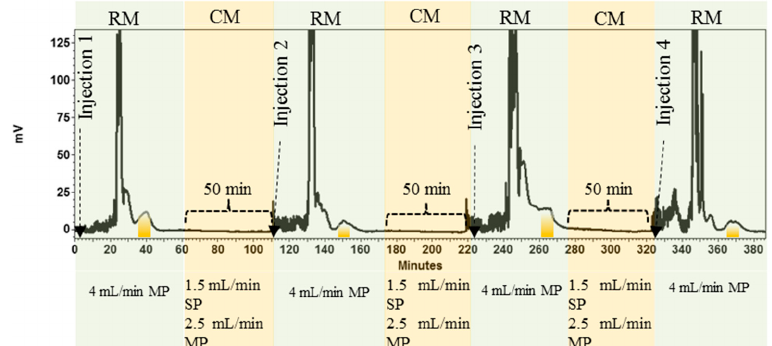
Figure 4. Isolation of myxoxanthophyll by a multi-injection HPCCC method. Biphasic solvent system: System 7 ( n -Hep:EtOH:H 2 O, 2:4:4, v / v / v ). Elution modes: Reverse (RM) and co-current (CM) elution modes. Loading per injection: 70 mg of S. salina extract. Runs: 4 consecutive injections. MP: mobile phase (lower phase of system 7). SP: stationary phase (upper phase of system 7). Rotational speed: 1400 rpm. Column temperature: 28 °C. Detection 478